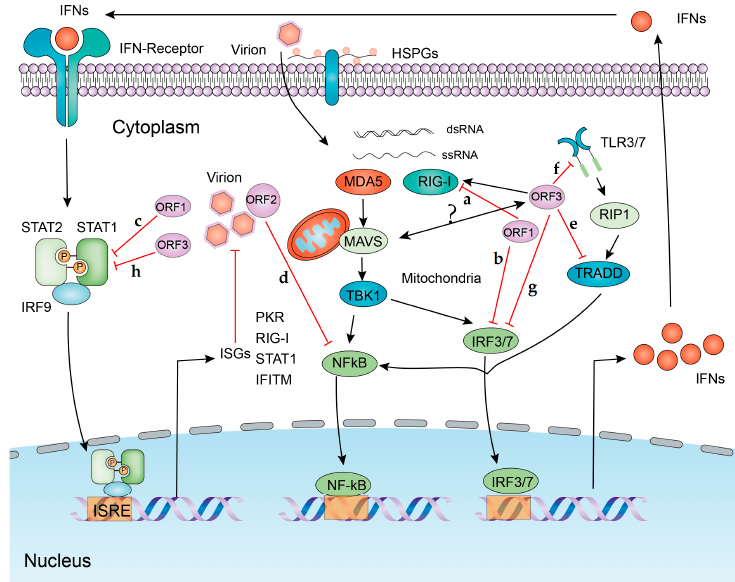
Figure 1. The interplay of the interferon (IFN) antiviral signaling and HEV. Upon infection, HEV is recognized by the host pattern-recognition receptors, including MDA5, RIG-I, TLR3, and TLR7. This triggers their downstream cascades, including IRF3 and NF- κ B, leading to the production of IFNs. Subsequently, IFN binds to the receptors and results in phosphorylation of STAT1 and STAT2. Phosphorylated STAT1 and STAT2 form a complex with IRF9 (ISGF3). This complex translocates to nucleus and binds to IFN-stimulated response element (ISRE) to induce the transcription of antiviral IFN-stimulated genes (ISGs). RIG-I and MDA5 have been identified to inhibit HEV replication. On the other hand, HEV has evolved strategies to evade host IFN response. ORF1 inhibits phosphorylation of STAT1 and IRF3 as well as deubiquitination of RIG-I. ORF2 inhibits activation of NF- κ B. ORF3 blocks phosphorylation of STAT1 and IRF3, but also has been reported to induce IFN production through increased activation of RIG-I. a, b, c, d, e, f, g, and h indicate the important interactions between viral proteins and host factors.